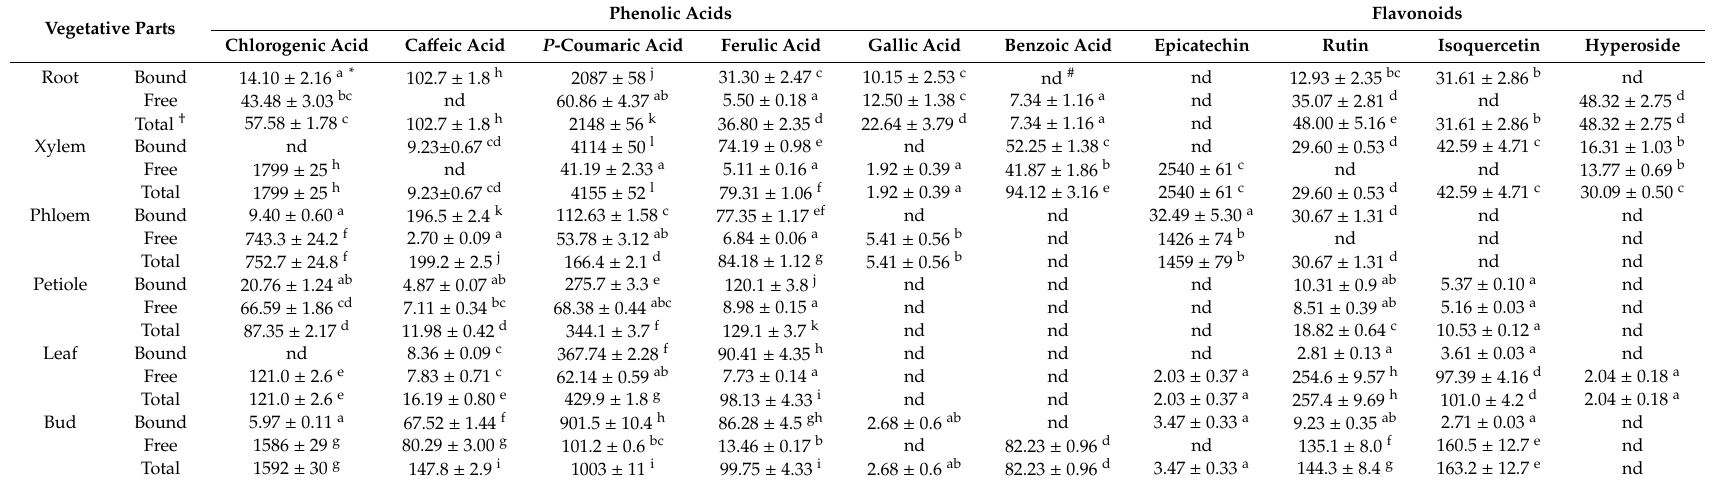
Table 1. Phenolic composition of di ff erent vegetative parts from Boehmeria nivea